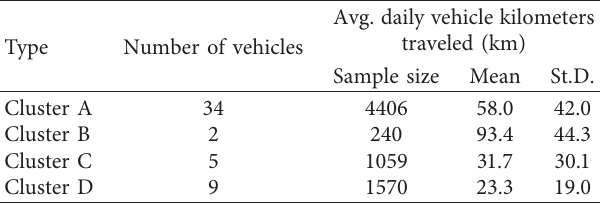
Table 3: Summary metrics of different clusters.